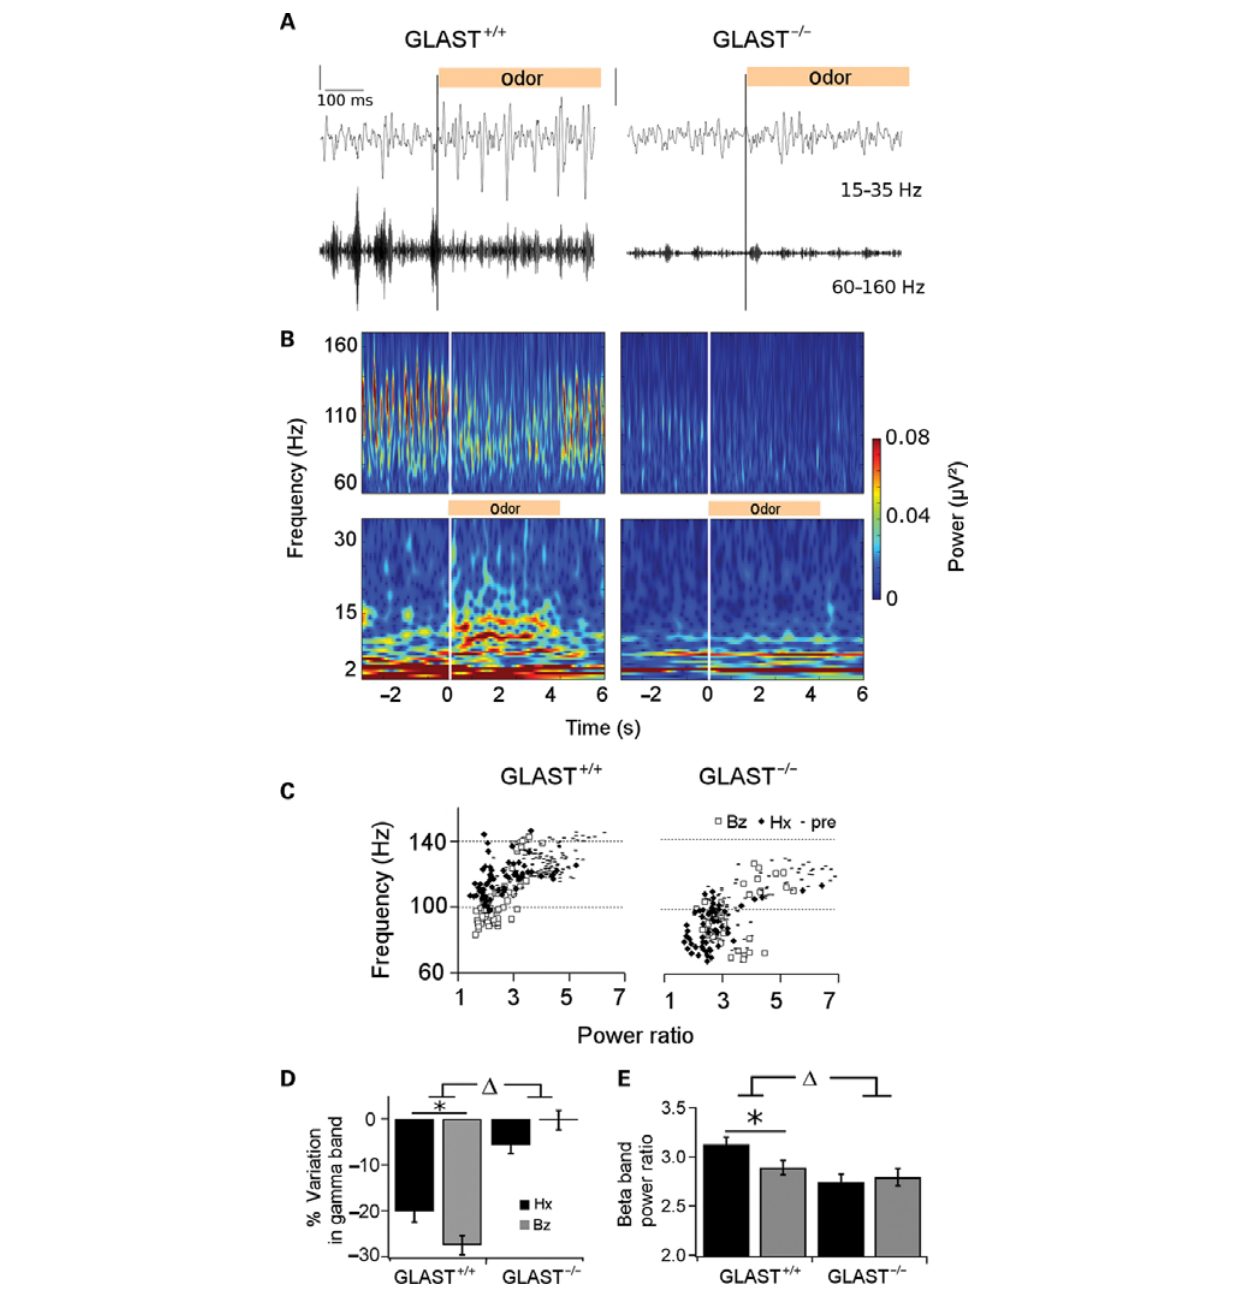
are plotted as function of their power ( x -axis) and frequency ( y -axis).The frequency shift is clear for both genotypes during odor sampling even though frequency is slower in GLAST − / − mice. Peaks have a lower frequency under benzaldehyde than under hexanal in GLAST + / + , no difference in repartition is observed for GLAST − / − mice. (D) Decrease in high gamma band (60–160 Hz) power illustrated as the variation (in %) of the average power value comparing the two time–frequency plots (pre-odor from –8 to –4 s) and odor periods (1–5 s) for hexanal 2% (black bars) and benzaldehyde 2% (gray bars). No gamma decrease is observed in GLAST − / − ( n = 4) compared to GLAST + / + ( n = 4) mice. (E) Values of beta peaks power for both odors (hexanal 2% in black and benzaldehyde 2% in gray bars) in GLAST + / + and GLAST − / − . Power of the peaks is significantly lower in GLAST − / −